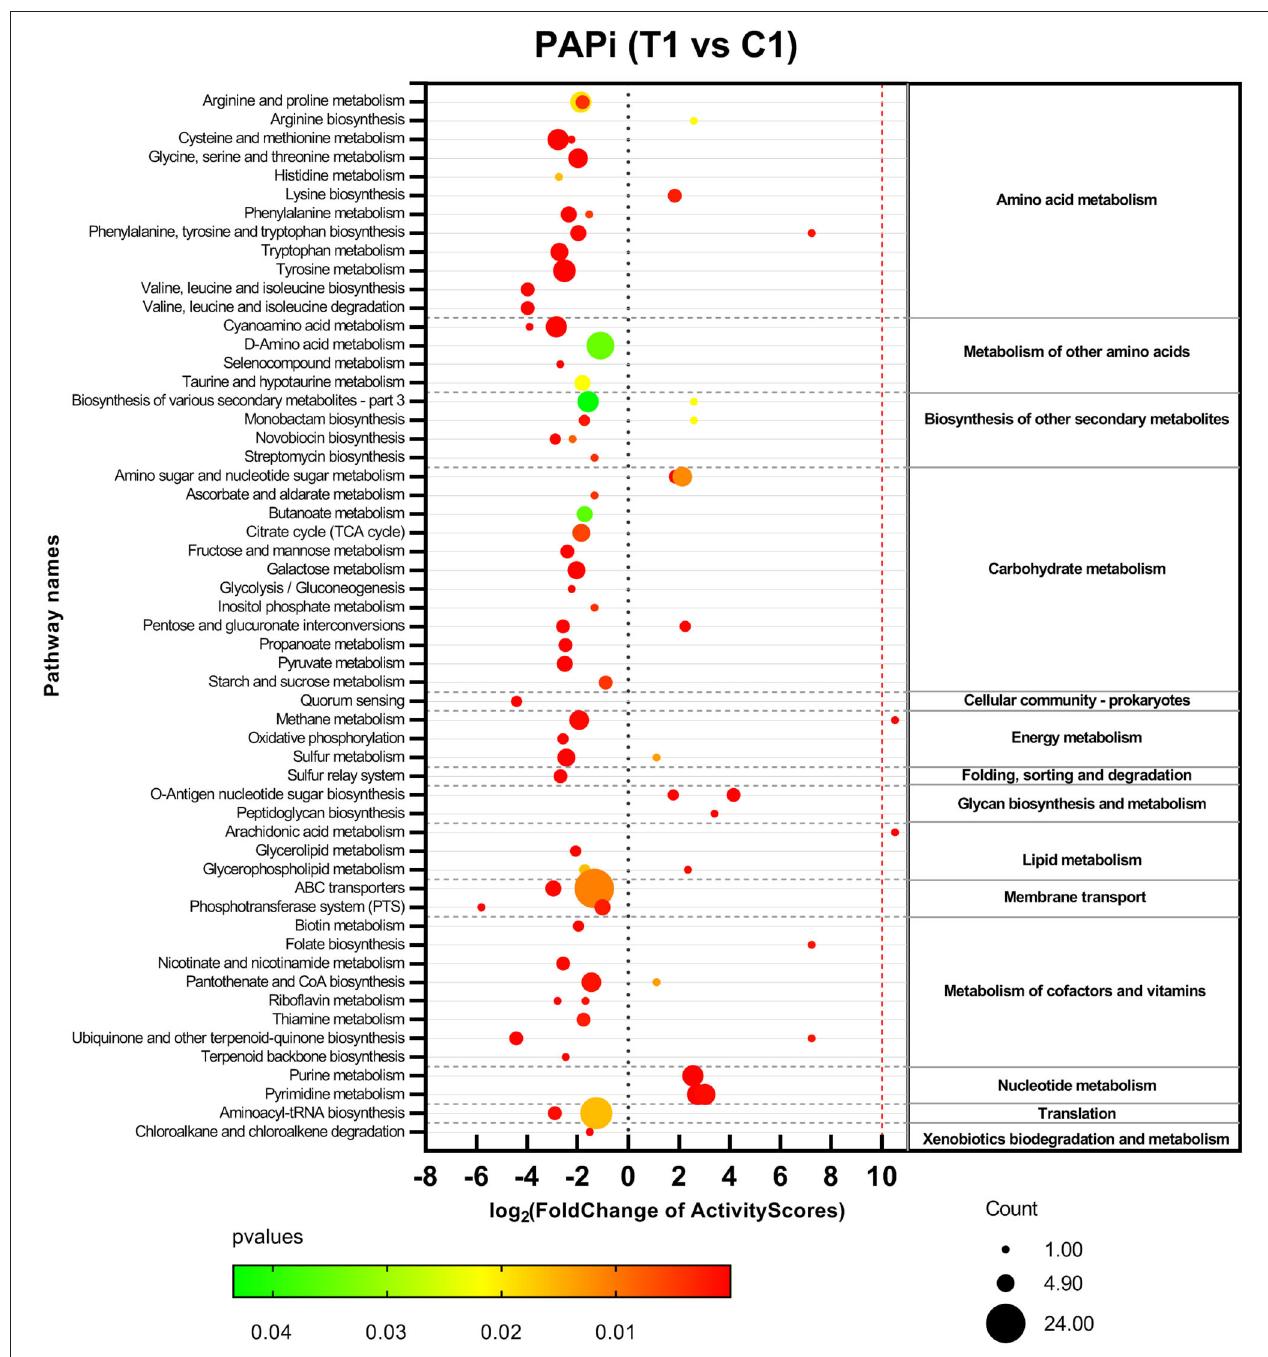
FIGURE 2 | Activities profile of metabolic pathways in comparison with BBR-exposed group (T1) vs. growth control group (C1). Results from GC-MS and LC-MS datasets were merged. The color and size of bubbles represent the statistical significance and the number of metabolite species matched to the pathways,